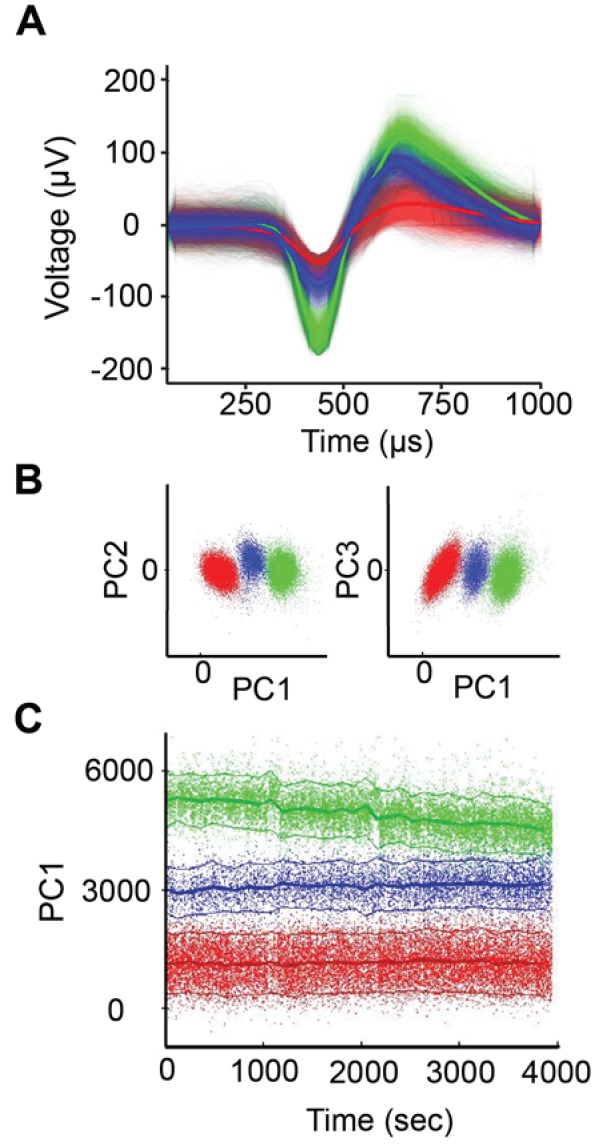
Spike sorting example.(A) Example of single-unit spike-sorting in one session with the U-probe. There were three distinct spike waveforms isolated from the same electrode. (B) Clustering of the three units from panel A in principal component analysis (PCA) space. (C) Amplitude of PC1 as a function of time for the three units. Notice that the green cell decreases its amplitude in time, but without overlapping with the other units.